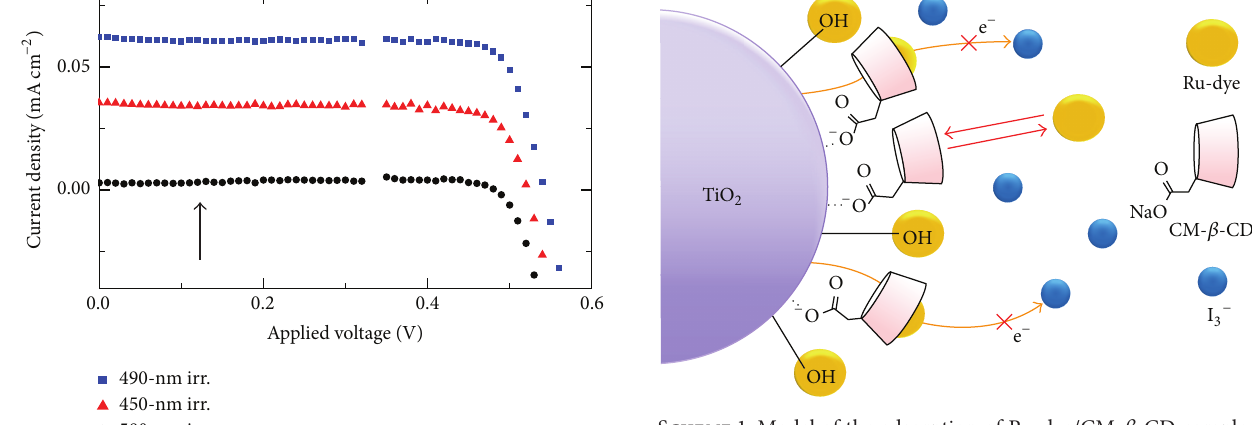
Scheme 1: Model of the adsorption of Ru-dye/CM- 𝛽 -CD complex onto TiO 2